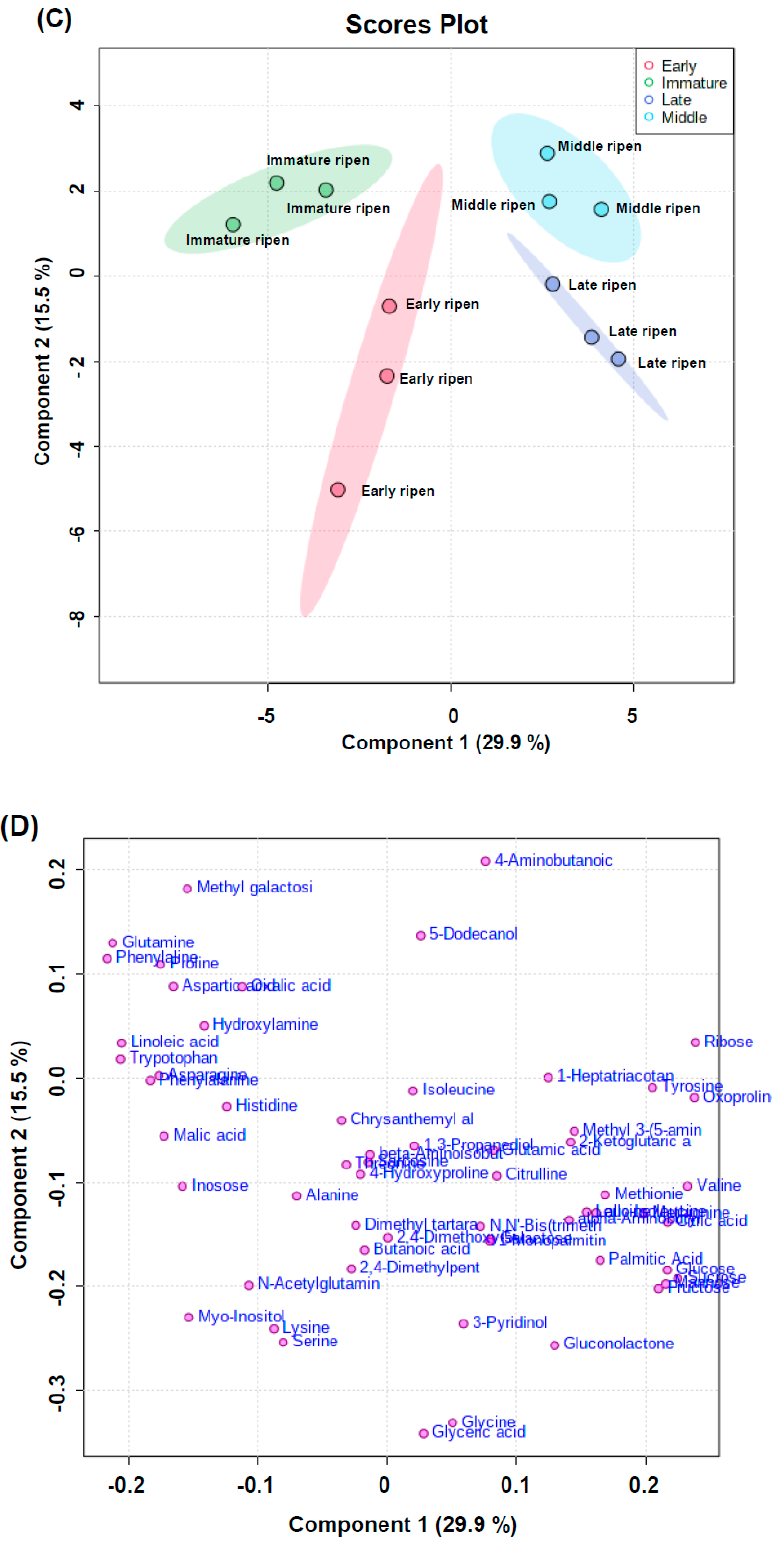
Figure 5. Chromatograms of water-soluble compounds ( A ) and amino acids from rose hip flesh ( B ) by GC-MS analysis. Partial least squares-discriminant analysis (PLS-DA) score plot ( C ) and loading plot ( D ) derived from GC-MS data of various ripening stages.